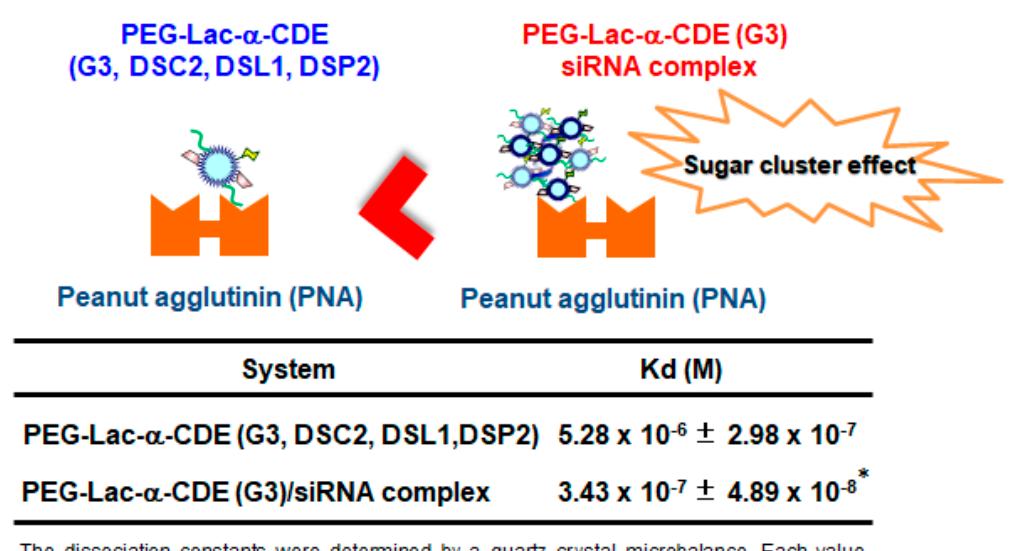
Figure 7. Interaction of PEG-Lac- α -CDE (G3, DSC2, DSL1, DEP2) and its siRNA polyplex with Peanut agglutinin. The dissociation constants were determined by a quartz crystal microbalance. Each value represents the mean ± S.E. of 3 experiments. * p < 0.05, compared with PEG-Lac- α -CDE (G3, DSC2, DSL1, DSP2).